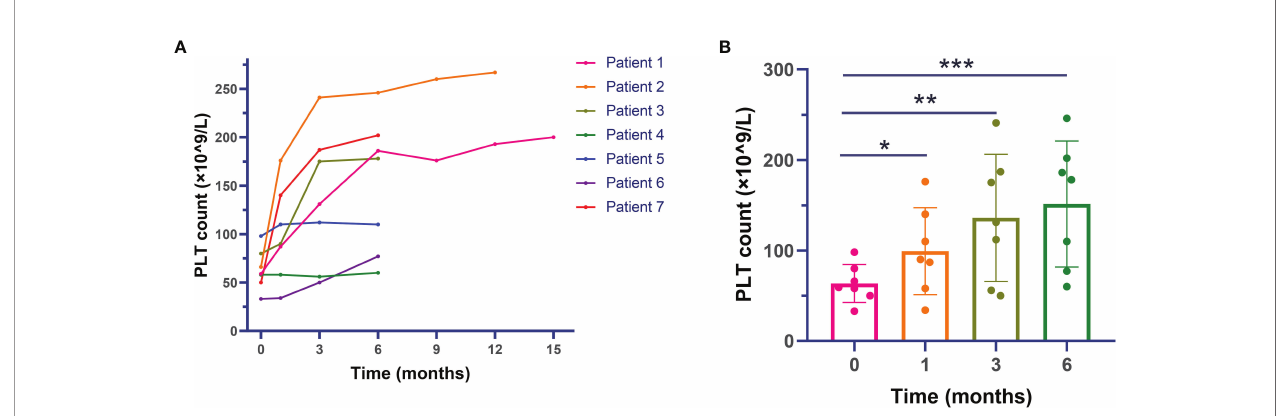
FIGURE 1 | Changes in platelet levels after sirolimus therapy in primary antiphospholipid syndrome patients with thrombocytopenia. (A) Platelet count of individual patients during the whole follow-up. (B) Median platelet count of included patients during the fi rst 6 months. *: comparison between baseline and month 1 with p < 0.05; **: comparison between baseline and month 3 with p < 0.05; ***: comparison between baseline and month 6 with p <